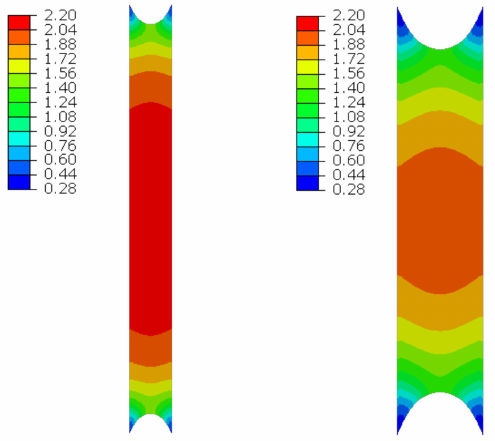
Figure 17. Deformations for scaling factor 1.0 and Cauchy stresses σ z in MPa for total load level. The width of the gap is equal to 1.0 cm, left graphic, and 2.0 cm, right